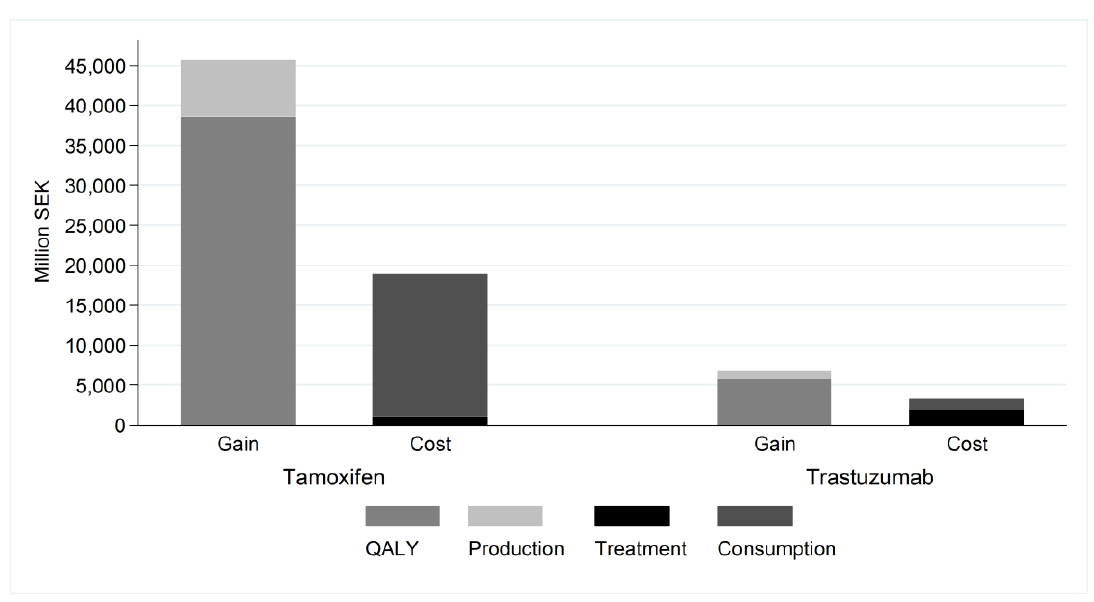
Figure 3: Increased gain and cost of hormone-responsive and HER-2 positive breast cancer following the introduction of tamoxifen and trastuzumab. Million SEK. Source Lundqvist et al.,